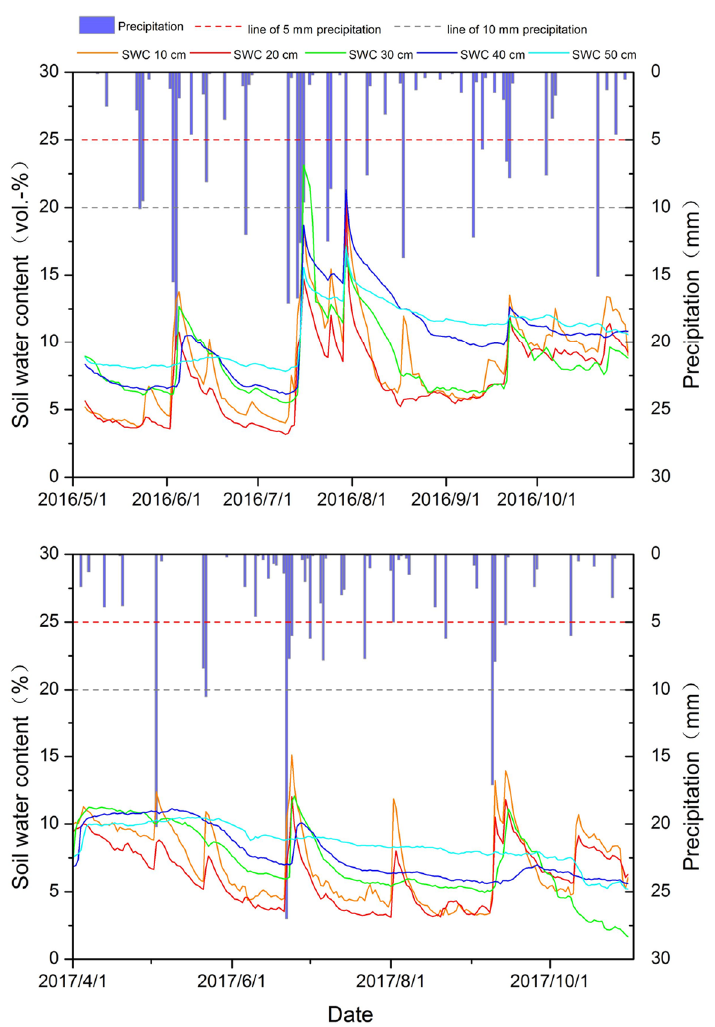
Figure 6. Dynamic of soil water content (SWC) between 10 cm and 50 cm and precipitation events during the growing season in different precipitation